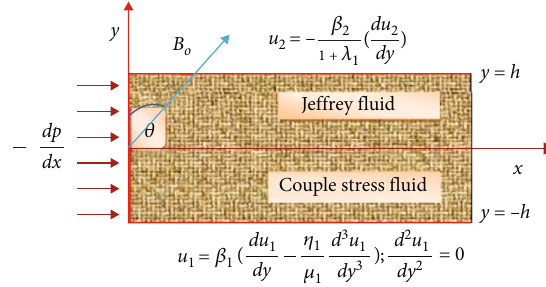
Figure 1: A schematic representation of the fl ow of two immiscible fl